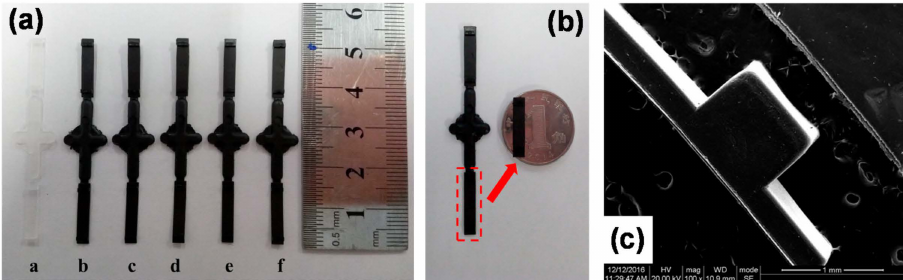
Figure 4. Photos ( a , b ) and SEM images ( c ) of PVDF/GP micro-parts with 1 wt% GP.